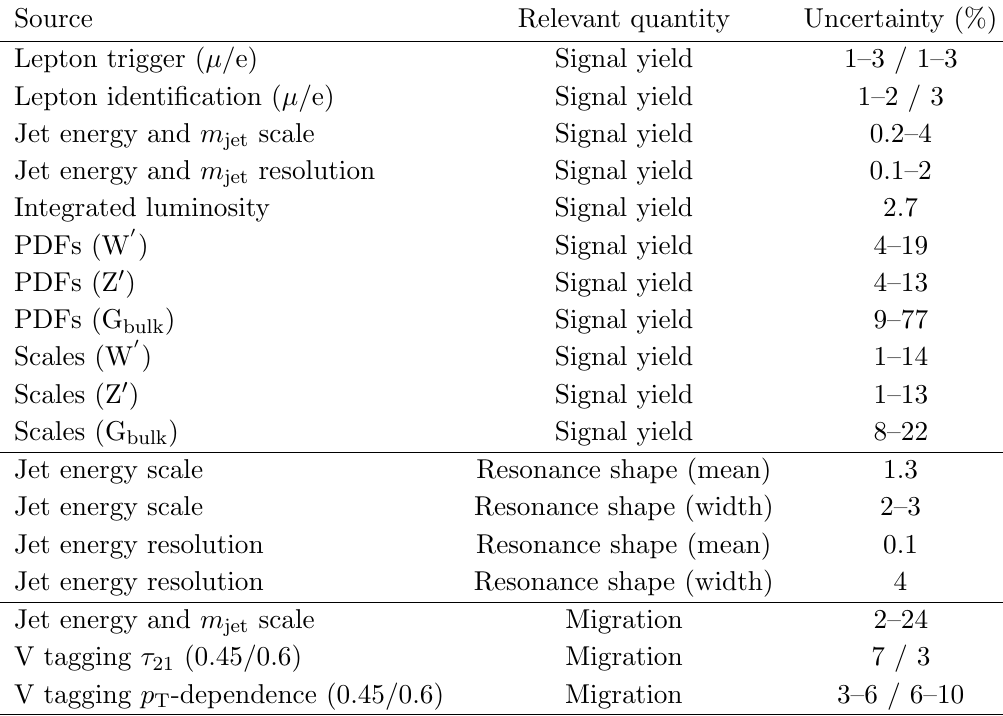
Table 8 . Summary of the signal systematic uncertainties for the ‘(cid:23) +jet analyses and their impact on the event yield in the signal region and on the reconstructed m VV shape (mean and width) for both muon and electron channels. The last three uncertainties result in migrations between event categories, but do not a(cid:11)ect the overall signal e(cid:14)ciency. The correlations among di(cid:11)erent categories are taken into